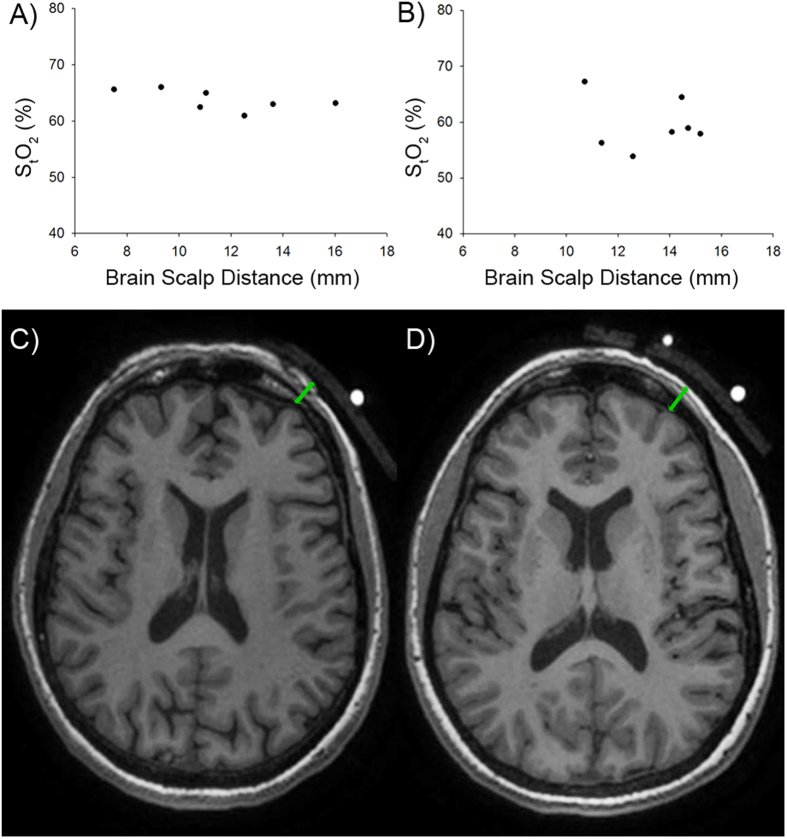
Combined MRI/NIRS measurement.There was no significant relationship between StO2 and brain scalp distance in controls (A) and MS patients (B). Representative images of a control and MS patient are shown in panel C and D, respectively. Bright dot represents the location of the Vitamin E capsule placed besides the source and detector.